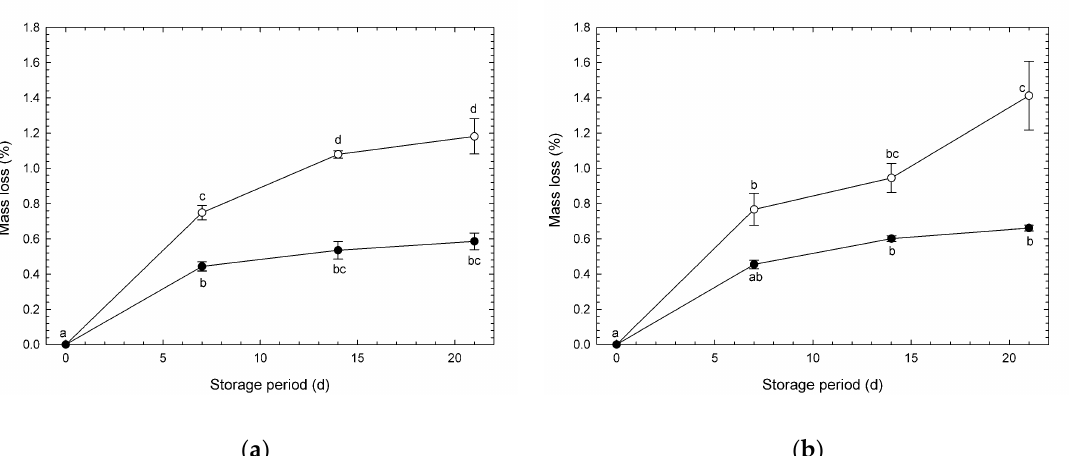
Figure 3. Mass loss of broccoli heads during storage at 1 °C. ( a ) Experiment #1: , normoxia; , O 2 /CO 2 = 2.5%/6.0% (+ N 2 to 100%). ( b ) Experiment #2: , normoxia; , O 2 /CO 2 = 2.5%/0.0% (+ N 2 to 100%). Values are means ± SE of three biological replicates. Significant differences ( p < 0.05) are denoted by different letters.